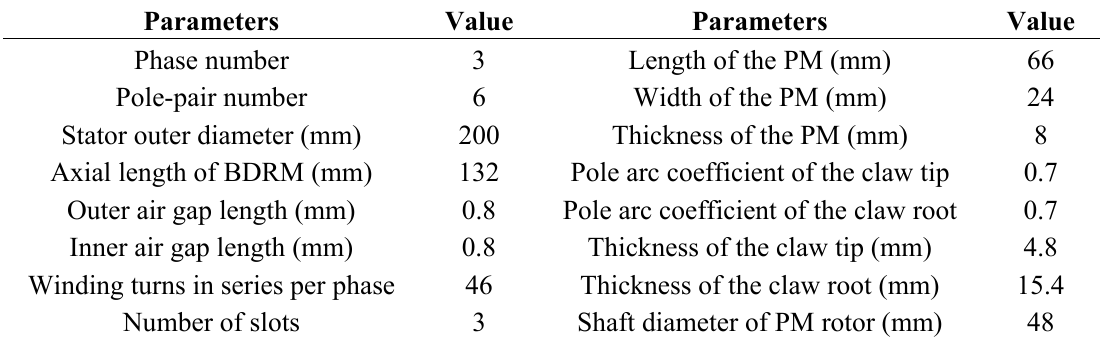
Table 1. Geometrical parameters of the BDRM